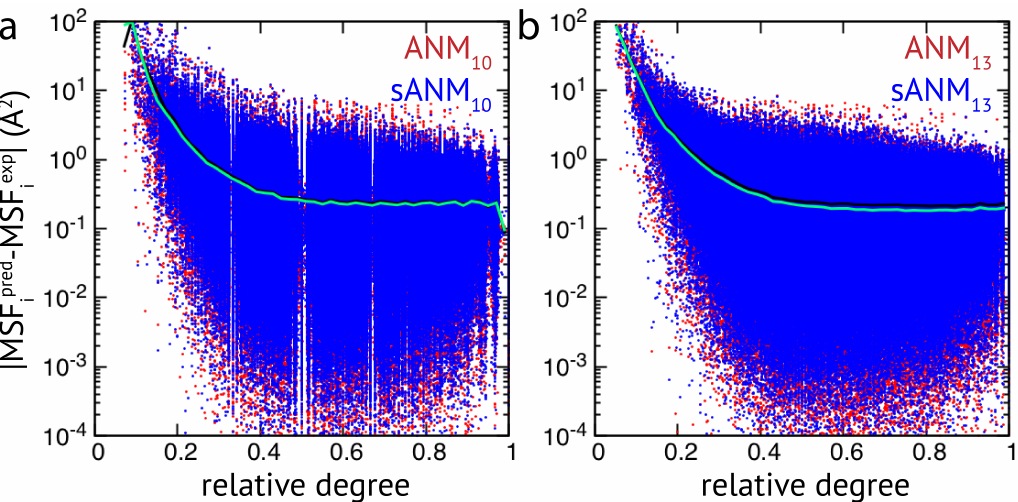
Figure A2. Extensive analysis of predictions by ENM variants. The error in MSF prediction for a set of more than 2000 protein structures is shown (in logarithmic scale). Each data point represents the absolute deviation of predicted and experimental MSF obtained for a single residue bead in a protein elastic network, as a function of its relative degree. ( a ) Red dots are obtained for ANM 10 and blue dots correspond to sANM 10 predictions. ( b ) ANM 13 is compared with sANM 13 . In both plots, the average absolute errors are indicated as black lines for sANMs and as green lines for ANMs.